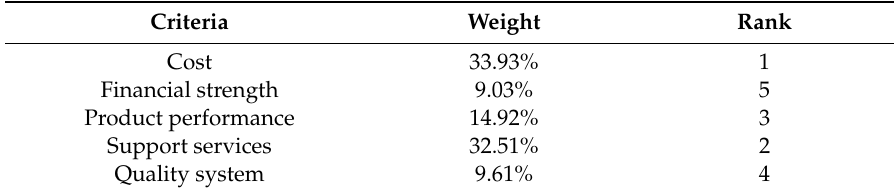
Table 4. The importance weights of the criteria.